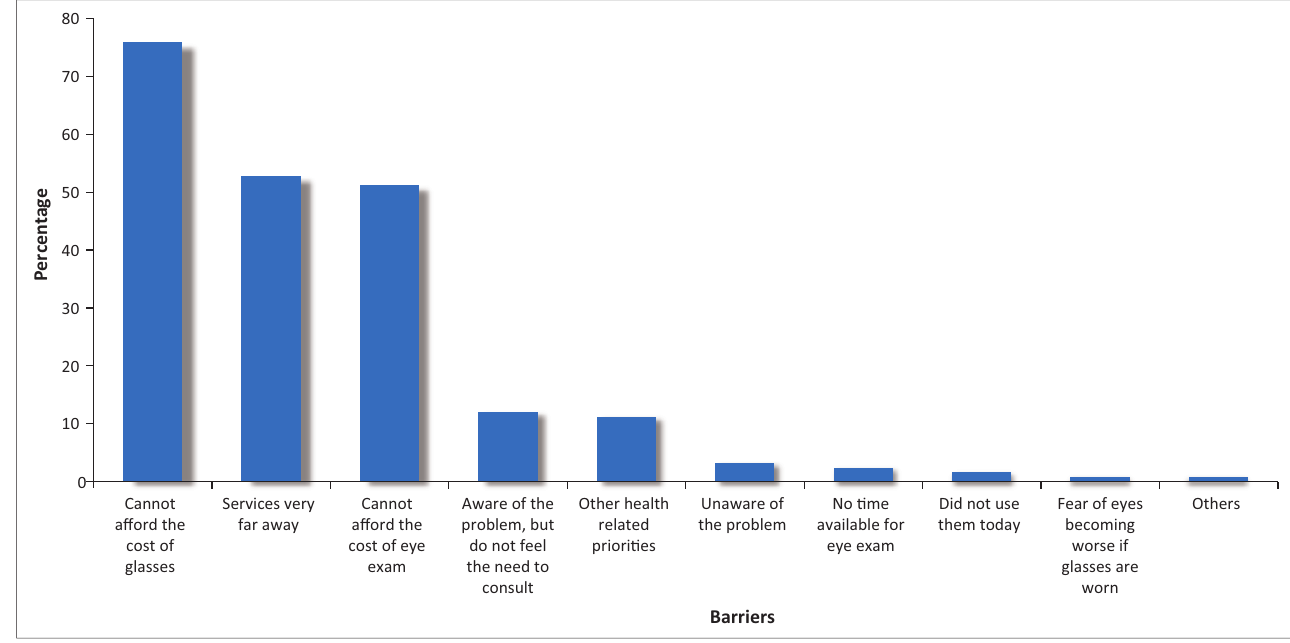
FIGURE 1: Barriers to uptake of refractive